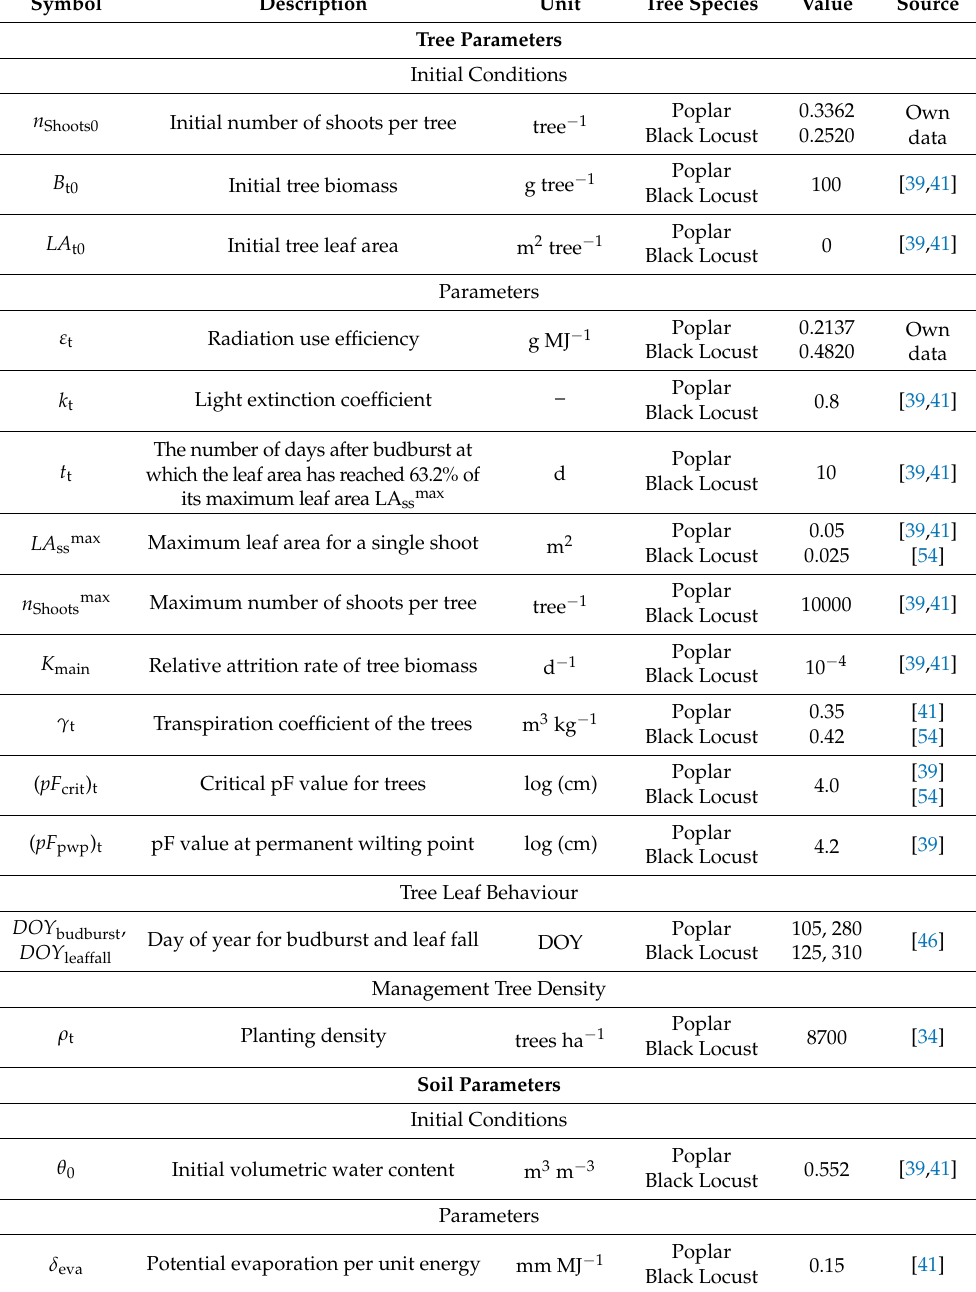
Table A1. Tree and soil parameter values used for the parametrization of the Yield-SAFE model for the SRC in Forst (north-eastern